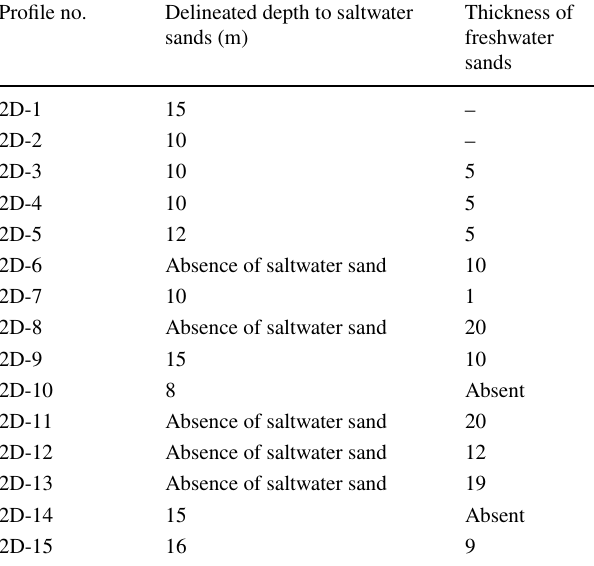
Table 2 Summary of the physico-chemical parameters of the ground-